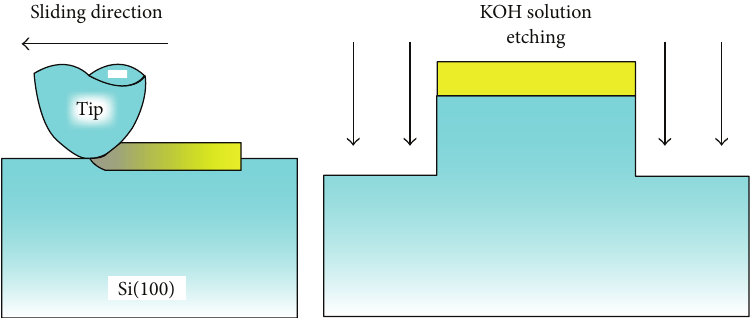
Figure 10: Profile etching model of silicon using a mechanochemically oxidized